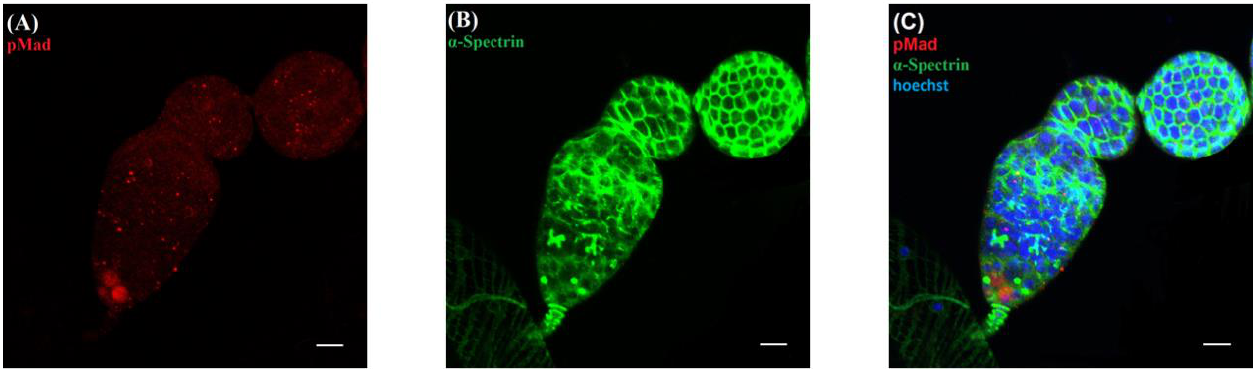
Figure 2. ( A ) For staining the GSCs, pMad antibody was used. ( B ) For staining single dots containing spectrosomes and fusomes, we used α -Spectrin. ( C ) CBs were differentiated from the GSCs and cyst based on the presence of single spectrosome-containing dots. Only GSCs and CBs have single dots containing spectrosomes. To stain DNA, Hoechst was used. Scale bar, 10 μ m.